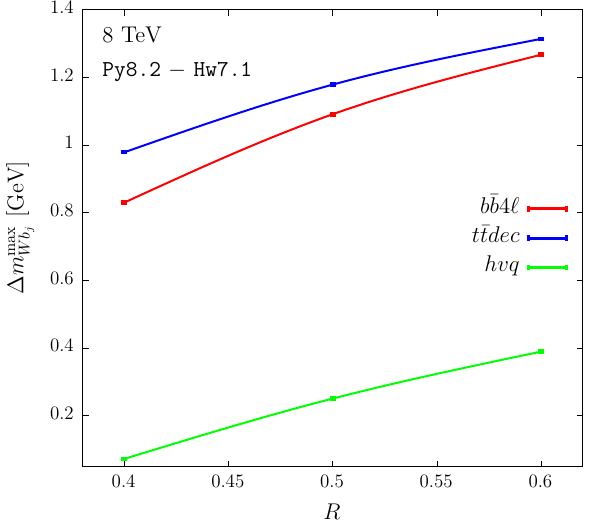
Fig. 13 Smeared d σ/ dm Wb distribution obtained by matching the j b ¯ b 4 (cid:4) generator with Pythia8.2 and Herwig7.1